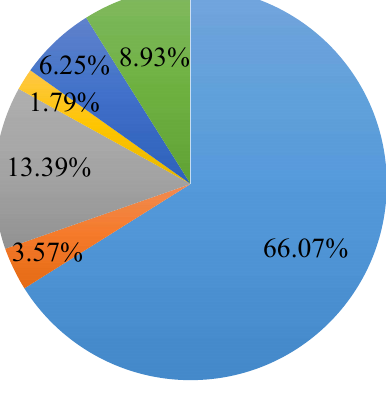
Figure 1. Faculties in which students have enrolled.